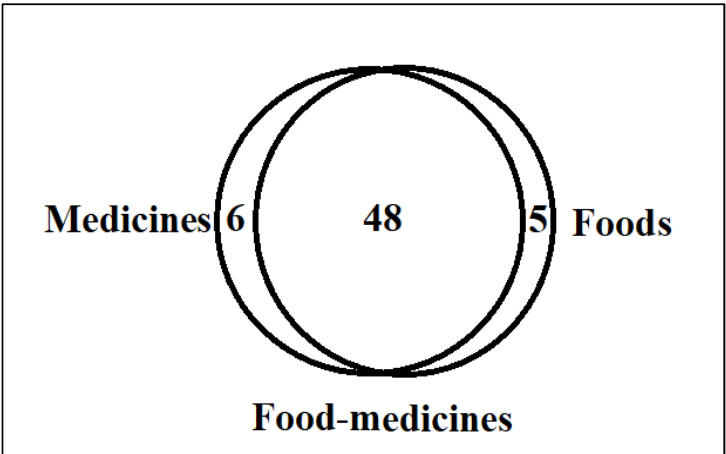
Figure 2. Venn diagram showing the different uses of locally gathered WFPs in the study